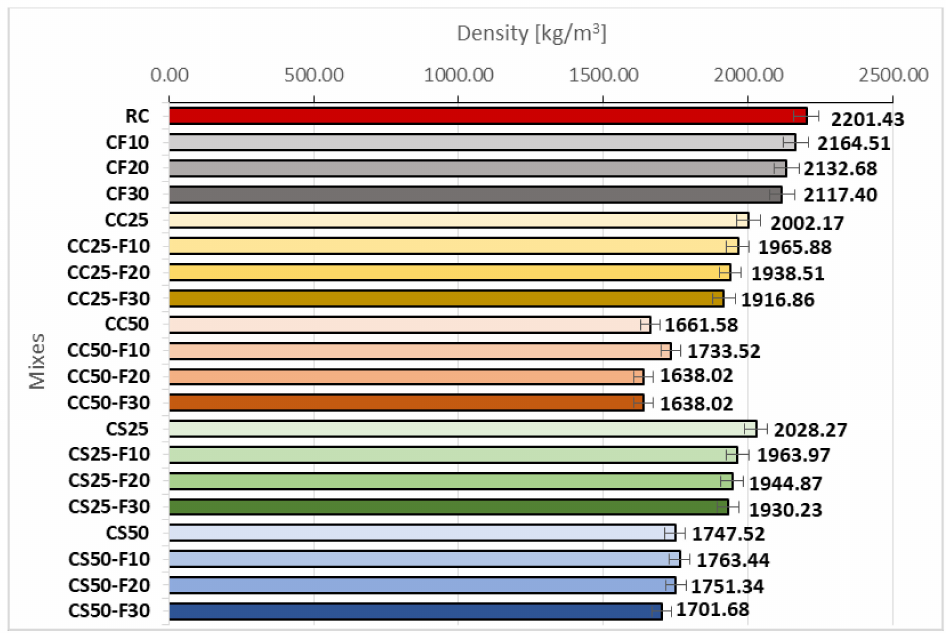
Figure 12. Density of composites with fly ash, corn cobs, and sunflower stalks, measured 28 days after casting [kg/m 3